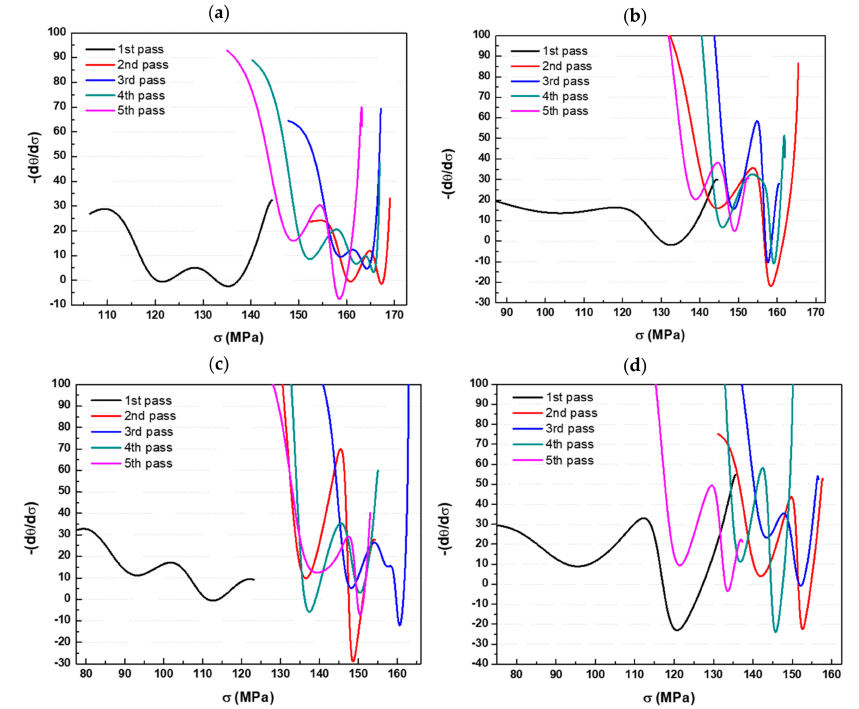
Figure 5. Plots of − (d θ / d σ ) versus σ used to identify the minima related to the initiation of dynamic transformation (DT) and dynamic recrystallization (DRX). The samples associated with ( a ) zero, ( b ) one, ( c ) two and ( d ) four roughing passes are presented